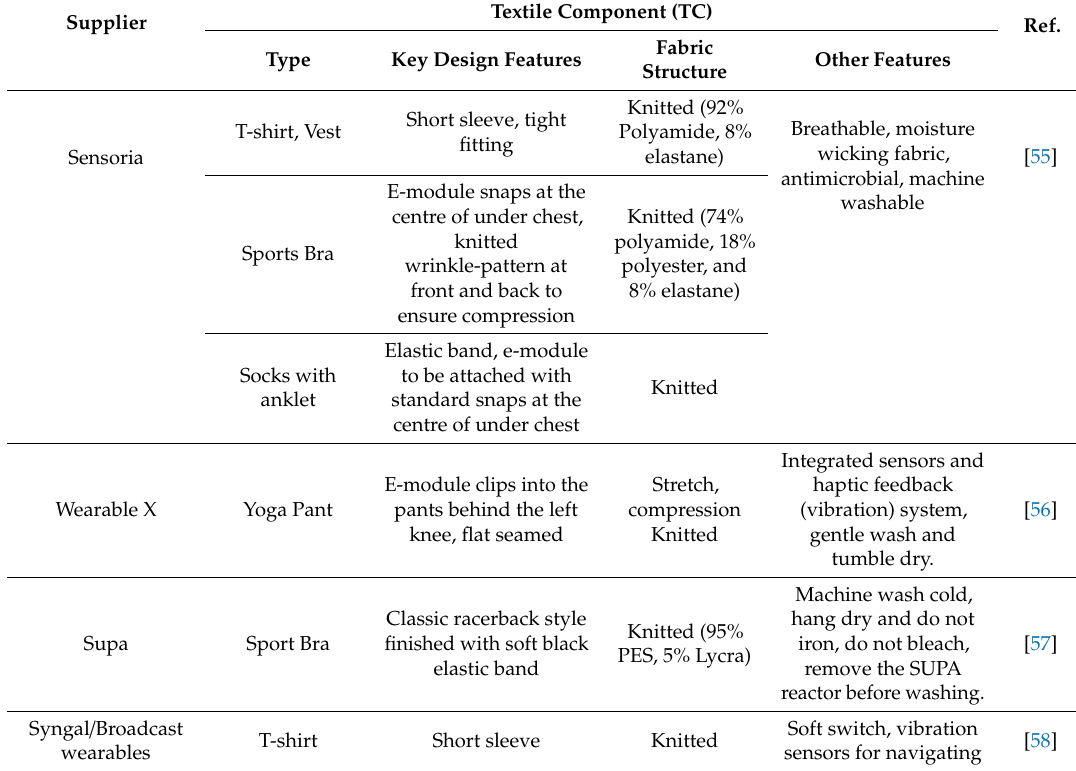
Table 6. Features of the textile components (TCs) of available SeCSs for fitness tracking.